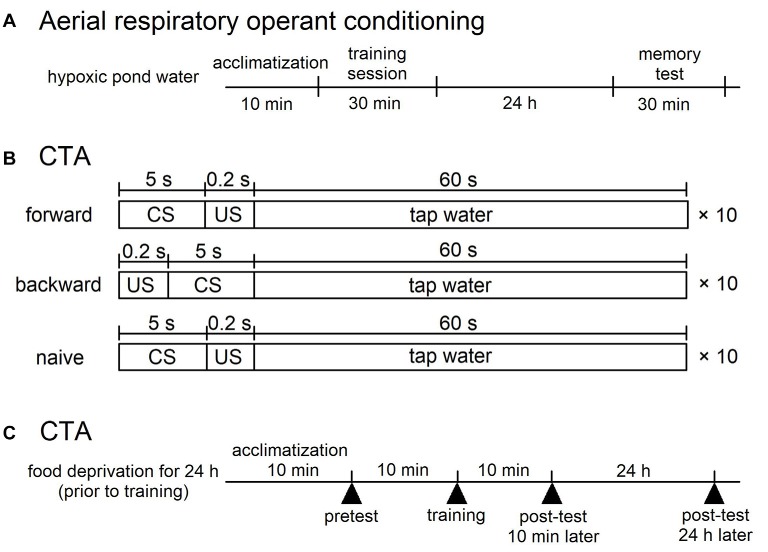
Training procedures for aerial respiratory operant conditining and conditioned taste aversion (CTA) in Lymnaea. (A) Aerial respiratory operant conditining. The pond water was made hypoxic (≤5% O2) by bubbling with N2 before training, and bubbling was then continued throughout training. Snails were acclimatized for 10 min before the training session. During the 0.5 h training session, each time a snail attempted to open its pneumostome at the water’s surface, the pneumostome was gently poked. For memory test, the protocol used for 0.5 h training session was repeated at 24 h after the training session. (B,C) CTA. (B) For forward conditioning (i.e., CTA training), snails were subjected to 10 pairings of sucrose administration (100 mM, conditioned stimulus, CS) for 5 s and electric shock (9 V, 0.4 μA, unconditioned stimulus, US) for 0.2 s. The inter-trial interval was 65.2 s. For backward conditioning, the stimuli were reversed. That is, 10 pairings of application of electric shock (US) for 0.2 s and application of sucrose (CS) for 5 s were used. The inter-trial interval was also 65.2 s in the backward confitioning. For naive control experiments, the CS and the US were replaced with the application of DW. The timng was the same as that of the forward training. (C) The time schedule is shown for training. Snails were deprived of food for 1 day before training (except Figure 5). A pretest and two post-tests were performed to count the number of feeding responses to sucrose (bites/min) for 1 min after the application of CS for 5 s. One post-test was performed 10 min after training, and the other post-test was done 24 h after training.